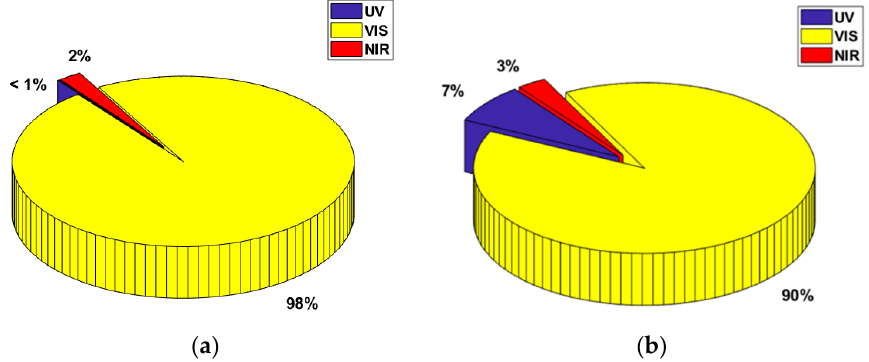
Figure 6. Percentage of optical radiation energy for electrical discharges generated in natural ester, Midel 1204, on electrode systems: needle–needle ( a ) and for surface discharges ( b ).